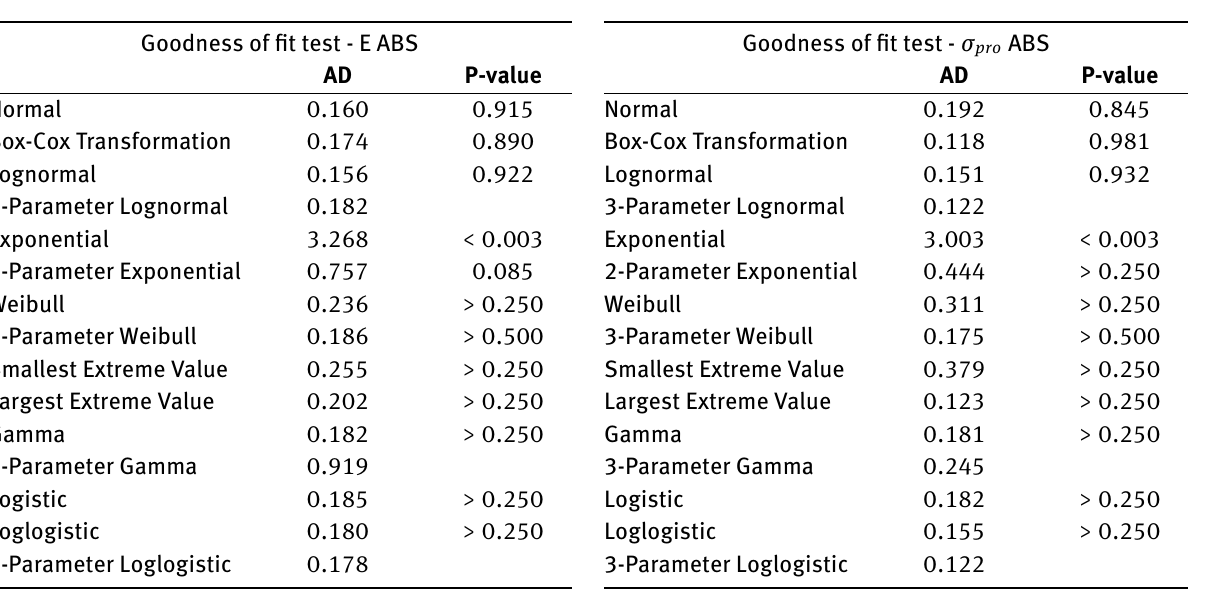
Table 7: Individual distribution identification for the ABS Young Modulus E.